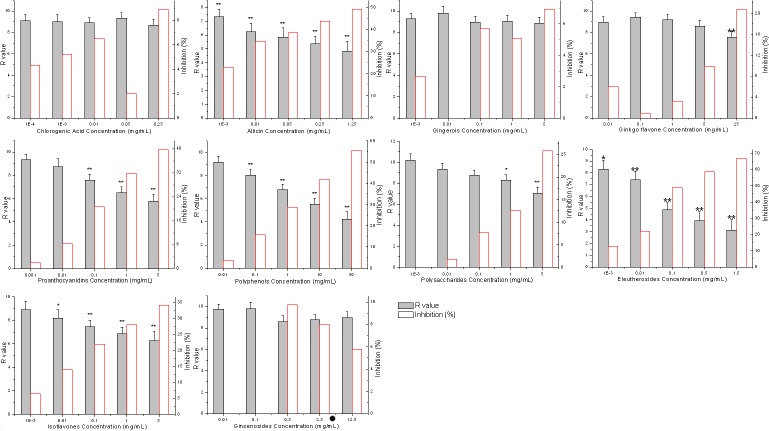
Effects of bioactive phytochemicals on umu gene expression in Salmonella typhimurium TA1535/pSK1002 exposed to 50 mg L−1 methotrexate.Inhibition \documentclass[12pt]{minimal}
\usepackage{amsmath}
\usepackage{wasysym}
\usepackage{amsfonts}
\usepackage{amssymb}
\usepackage{amsbsy}
\usepackage{upgreek}
\usepackage{mathrsfs}
\setlength{\oddsidemargin}{-69pt}
\begin{document}
}{}$(\text{%})=100\times ({R}_{\mathrm{control}}-{R}_{\mathrm{sample}})/{R}_{\mathrm{control}}$\end{document}%=100×Rcontrol−Rsample∕Rcontrol; ∗p < 0.05, ∗∗p < 0.01.